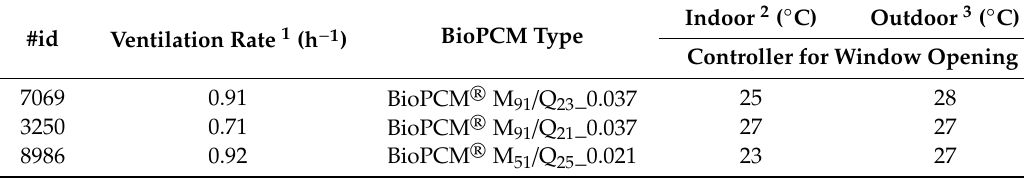
Table 3. Parameters results for Step 2.